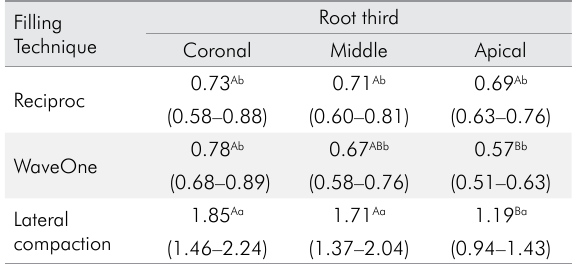
Table 2. Results for filling techniques and root thirds (Means, 95%CI) in MPa.